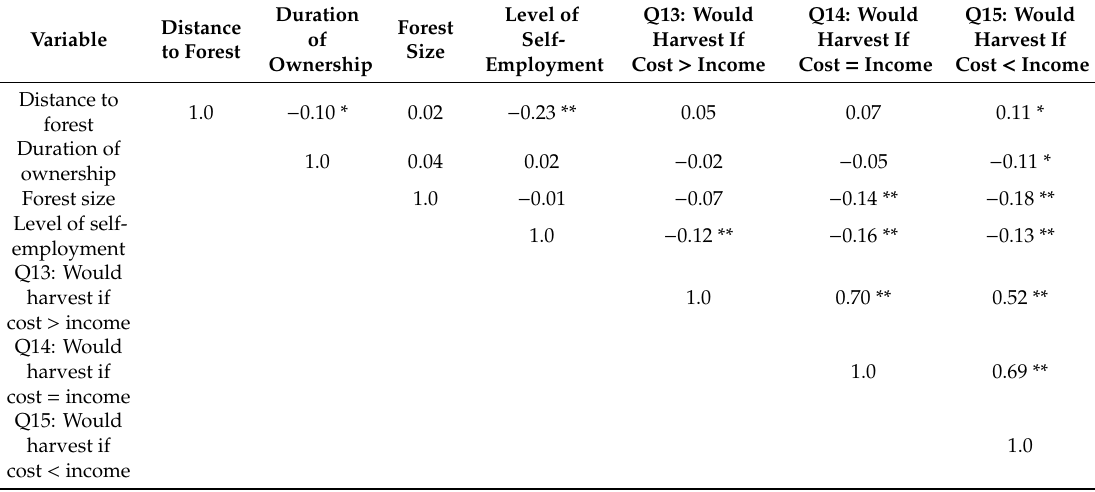
Table 8. Spearman’s rho correlations between scenarios (survey questions 13–15) for whole-tree harvesting and FFO characteristics. Responses are coded in ascending order for all variables (e.g., negative to positive or low to